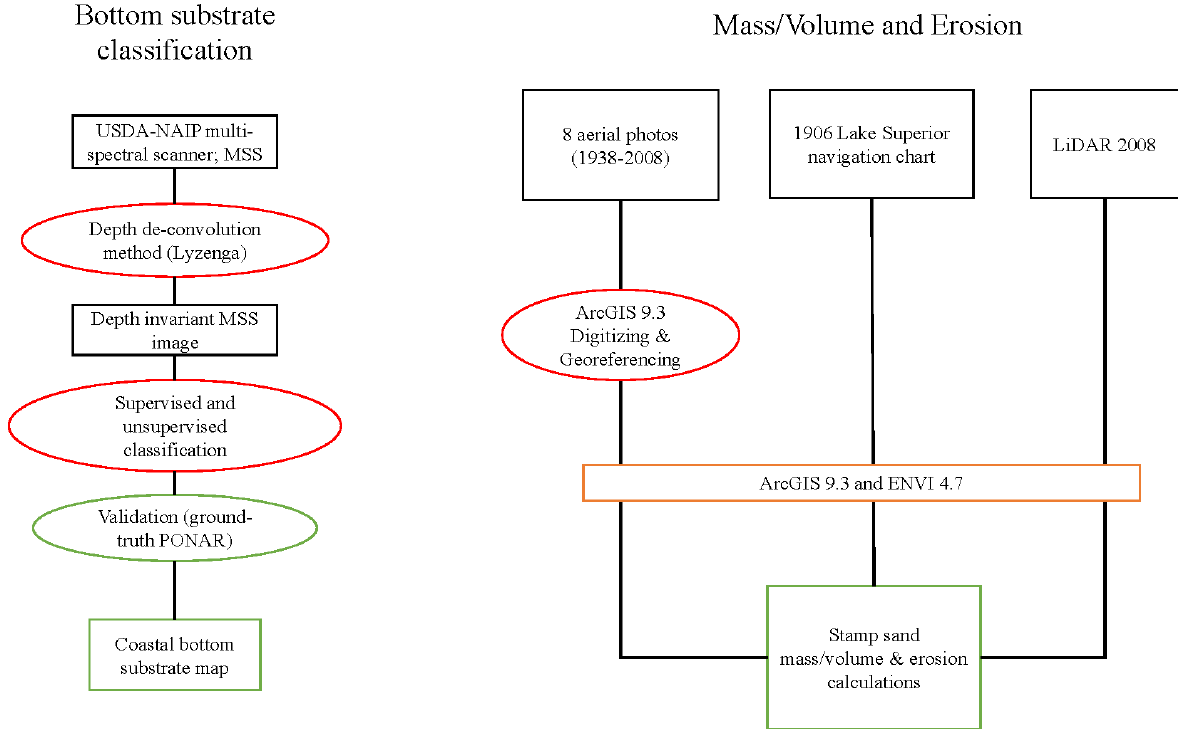
Figure 6. Flow chart for LiDAR, multispectral scanning (MSS) and aerial photography procedures used to calculate mass erosion and deposition and to classify substrates (black = primary data; red = method/tool/procedure; orange = software used; green = products). NAIP, National Agriculture Imagery